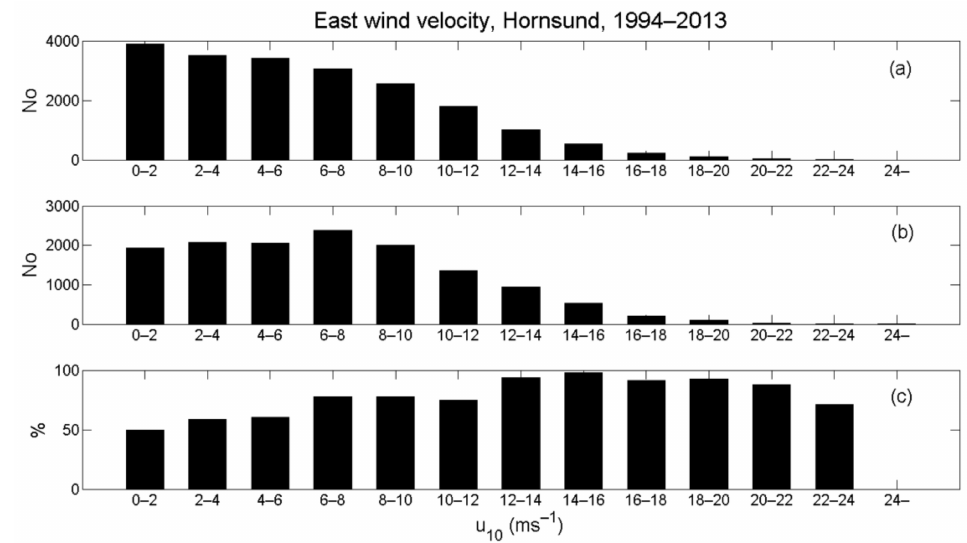
Figure 6. Number of east winds measured at Hornsund station for the years 1994–2013 subdivided by speed. ( a ) All measurements showing the east wind. ( b ) Measurements showing the wind from east when the land-sea breeze type circulation is observed on the basis of the difference in wind directions. ( c ) Percentage of winds from east when a mesoscale land-sea breeze observed, in total measured winds from east for each wind speed